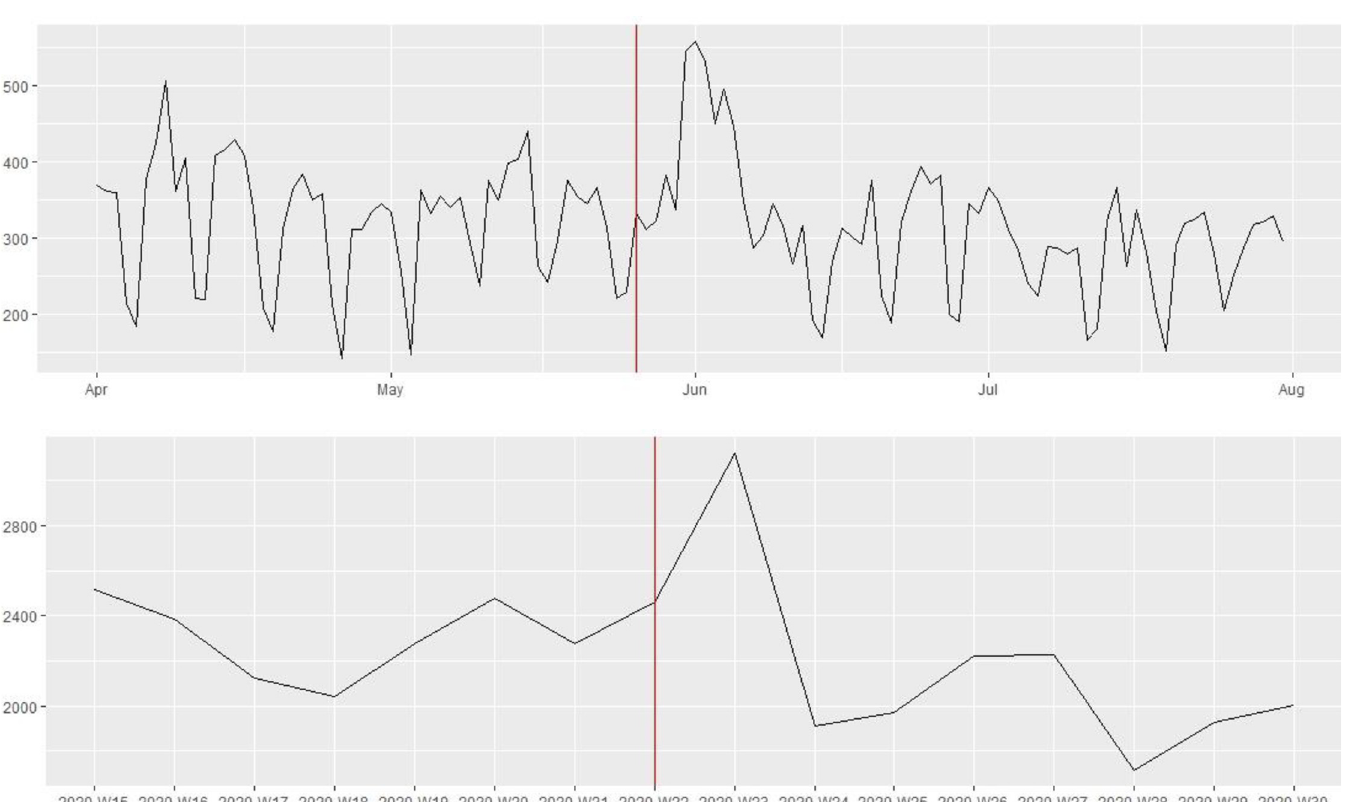
Fig 1. The number of tweets posted by the 115 major police departments in the U.S. before and after the killing of George Floyd on May 25 th , 2020 (above: Daily information; bottom: Weekly information).